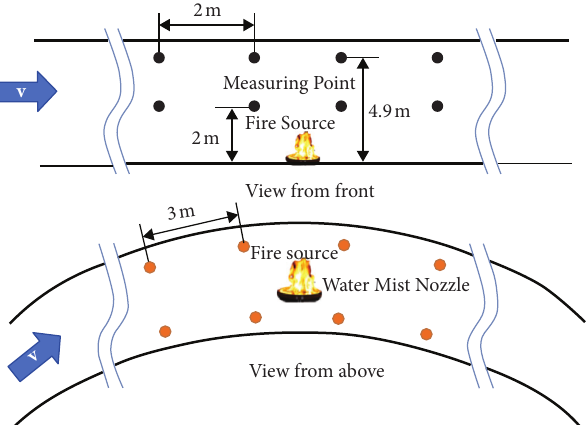
Figure 2: Schematic diagram of the arrangement of fire source, water mist nozzle, and measuring